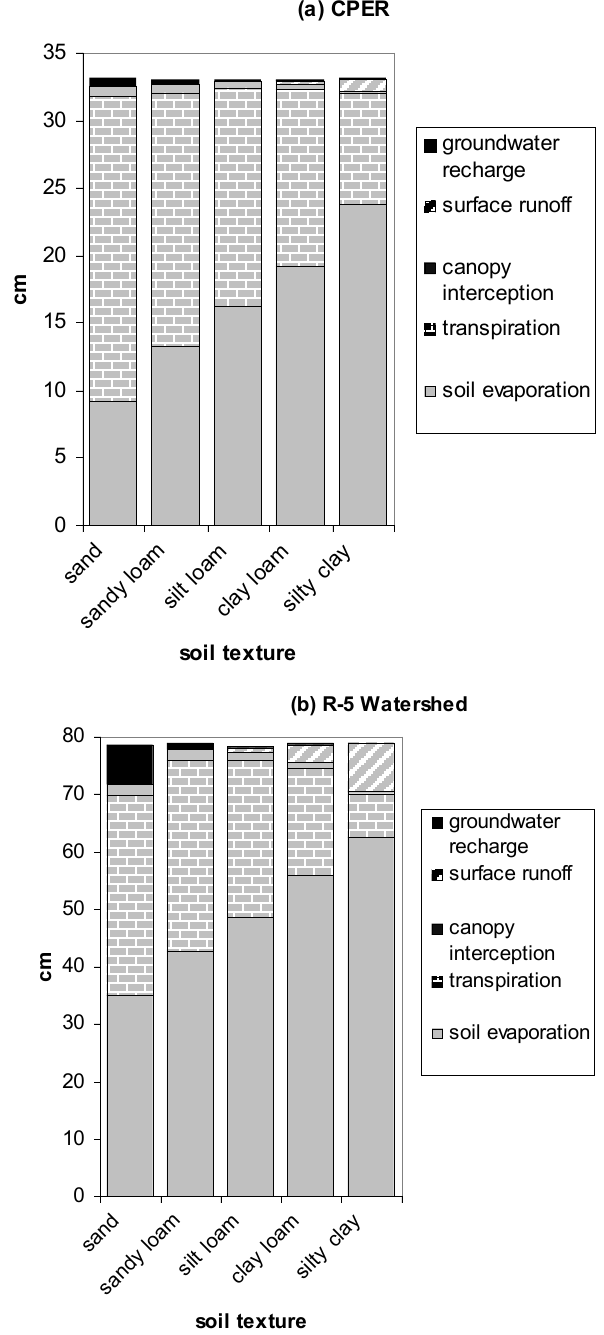
Fig. 12. Sensitivity of the components of the annual water balance to variations in soil texture for: (a) the CPER, and (b) the R-5 wa-